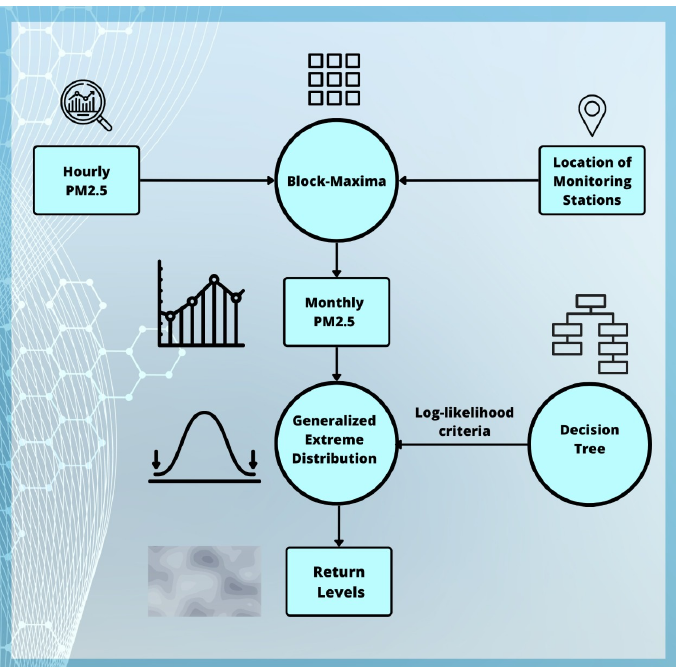
Figure 2. Graphical overview of the study